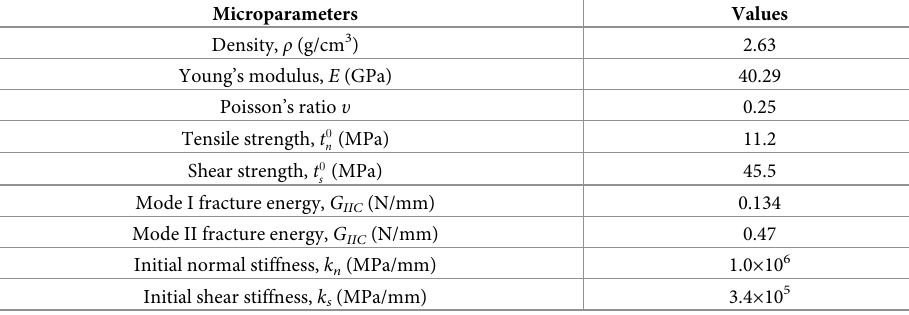
Table 2. Microparameters of the granite samples for the numerical